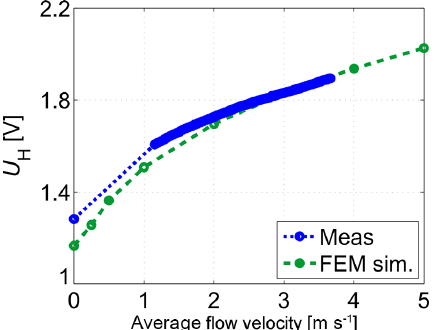
Figure 8. Simulation and measurement results (calorimetric ap- proach) of the heater voltage U H as a function of the average flow velocity in quasi-constant temperature